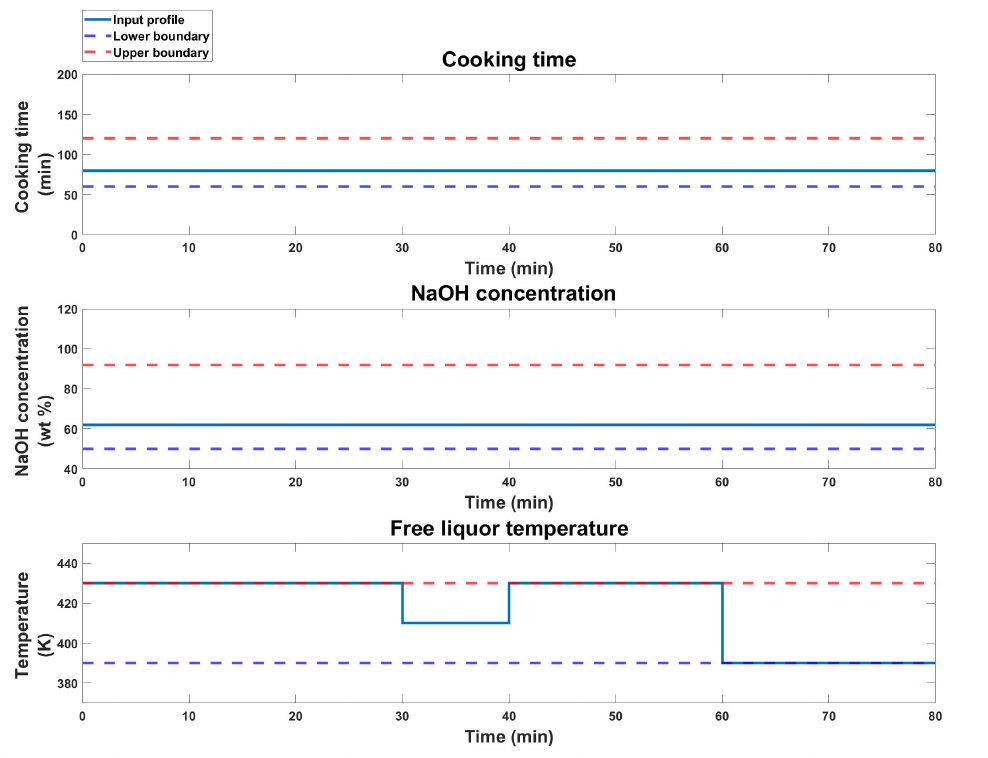
Figure 8. Optimal input profiles and bounds for the cooking time, NaOH concentration, and free- liquor temperature as obtained from the closed-loop